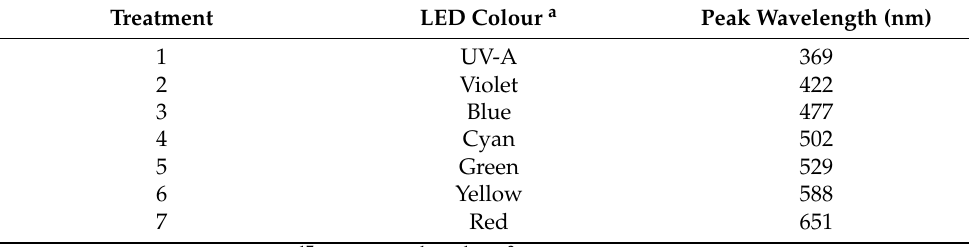
Experiment ii: Single-choice response of DEc to blue and yellow LEDs.